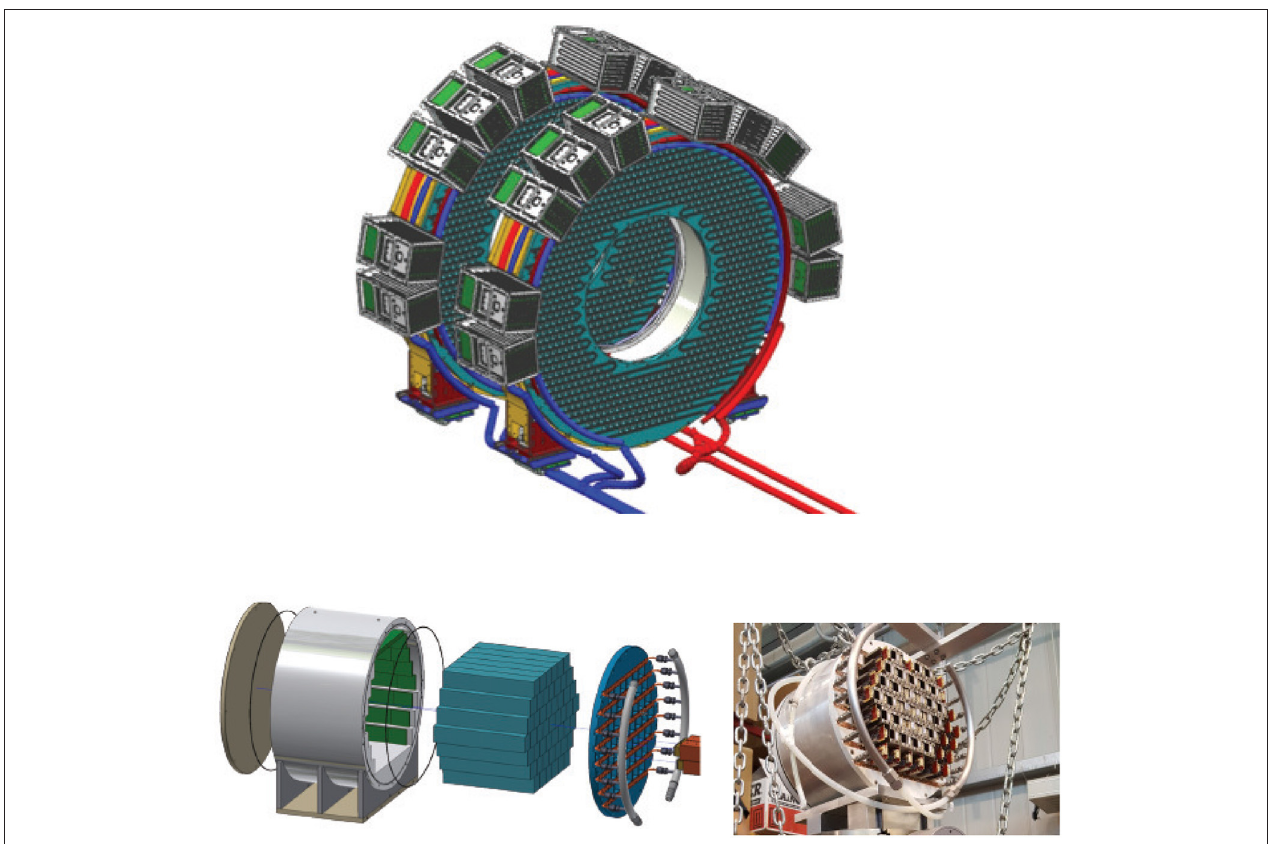
FIGURE 14 | A schematic of the Mu2e calorimeter showing the two disks, location of readout modules, and part of the calibration system. The bottom half of the Figure shows the assembly of the test module and a picture of the test module being moved into place.